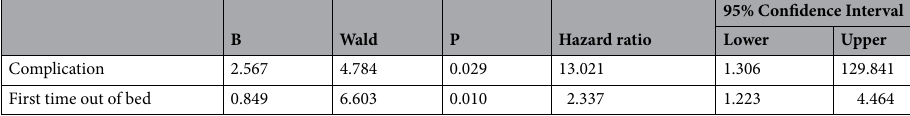
Table 4. Multivariate analysis of prognostic factors in patients with intertrochanteric fractures (Created by SPSS 24.0 software).